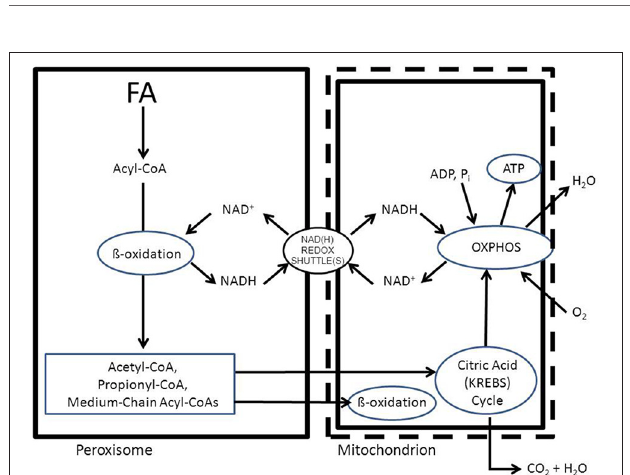
FIGURE 1 | Schematic diagram showing the functional interplay between peroxisomes and mitochondria in the beta-oxidation of fatty acids in peroxisomes. See text for detailed